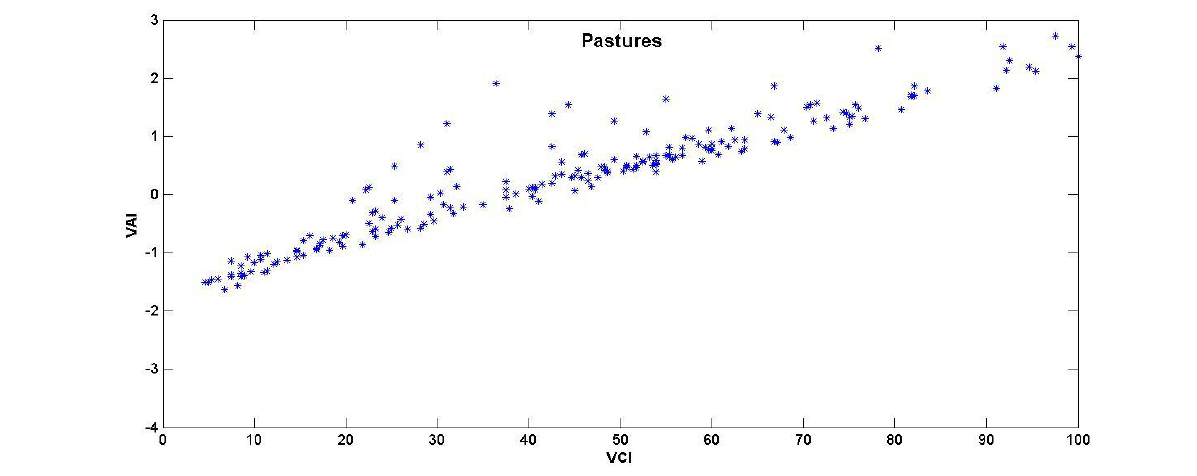
Figure 5. Intercomparison of VAI and VCI indexes, estimated from the full set of recordings corresponding to the rainy season months